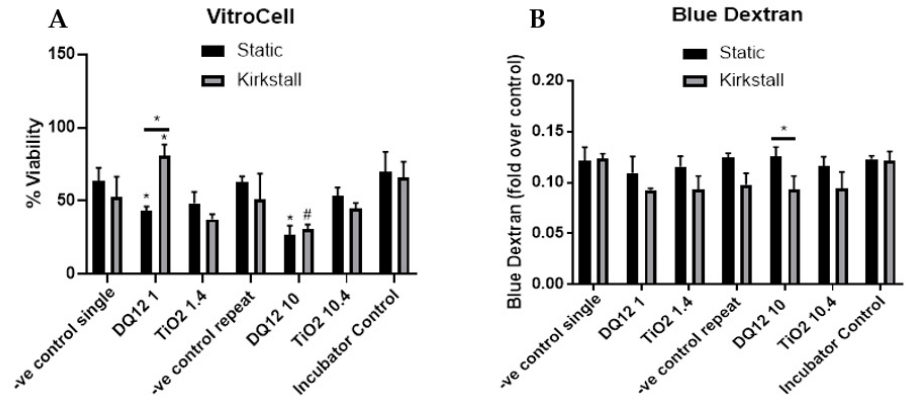
Figure 5. Viability and membrane integrity, 24 h post VitroCell exposure of both DQ 12 and TiO 2 on A549 + dTHP-1 co-cultures. Cells were exposed for 24 h at an ALI using the VitroCell method and incubated in either static or fluid-flow conditions, before analysing cytotoxicity ( A ) and membrane integrity (blue dextran) ( B ). N = 3 with all assays performed in triplicate. The data is presented as the mean ± standard deviation. Significance is denoted as the following: compared to the negative control p < 0.01 (*); compared to the lower concentration p < 0.01 (#); line is comparing the two systems p < 0.01